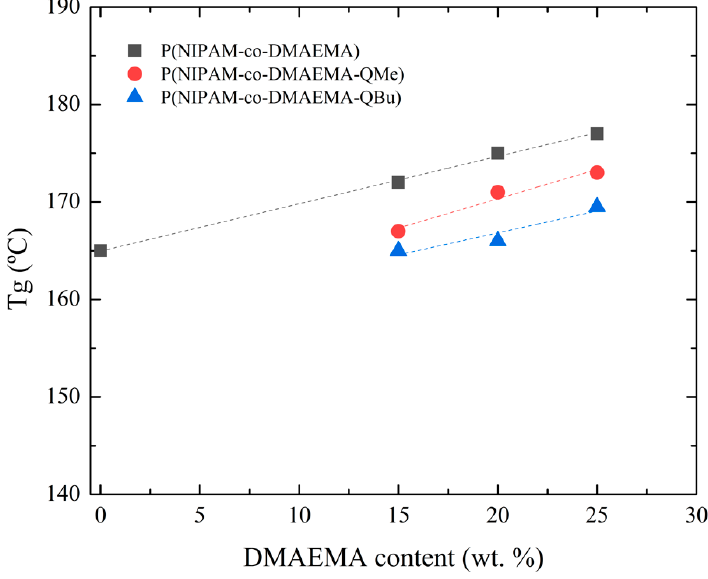
Figure 2. E ff ect of DMAEMA and its quaternization in the T g of the final Figure 2. Effect of DMAEMA and its quaternization in the T g of the final microgels.